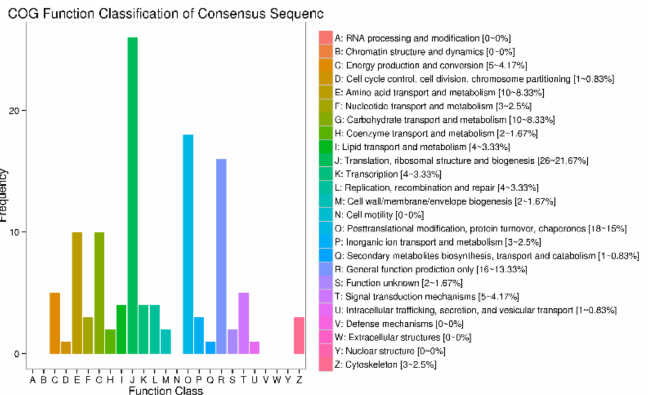
Figure 8. COG classification of all DEPs. Among all COG terms, “J: Translation, ribosomal structure, and biogenesis” (26 DEPs, 21.67%), “O: Posttranslational modi-fication, protein tumor, chaperones” (18 DEPs, 15%), and “R: General function pre-diction only” (16 DEPs, 13%) classified the most DEGs. The COG results of DEPs showed some differences compared with those of